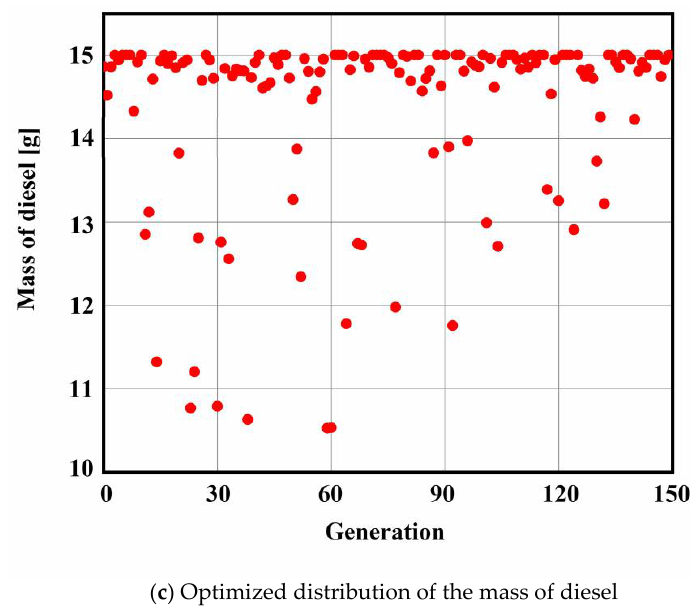
( c ) Optimized distribution of the mass of diesel Figure13. Optimized distribution of the target parameters. Figure 13. Optimized distribution of the target parameters.